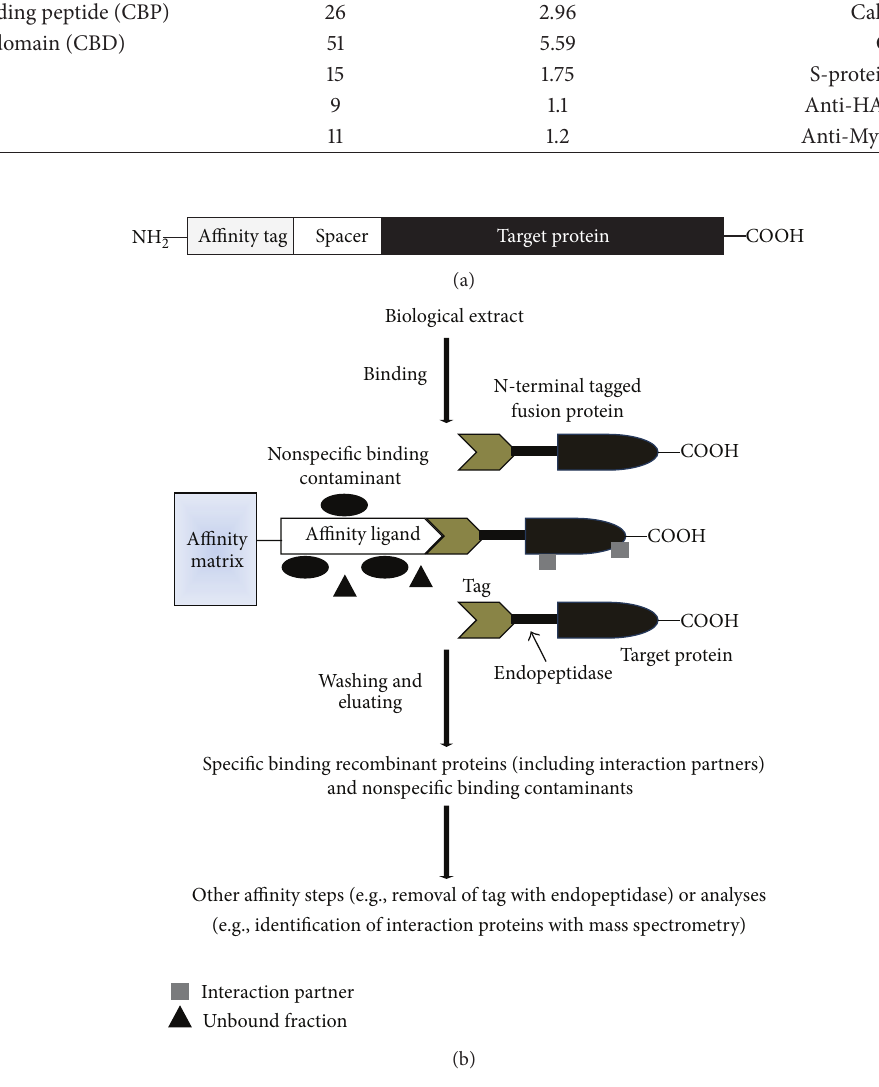
Figure1:(a)SchematicillustrationoftheN-terminaltaggedfusionprotein.Thespacerrepresentsanendopeptidasecleavagesequenceand/or solubility and folding enhancers. (b) Principle of fusion protein affinity purification and removal of the tag (only for N-terminal tagging). The interaction proteins will be copurified with the tagged fusion protein under native